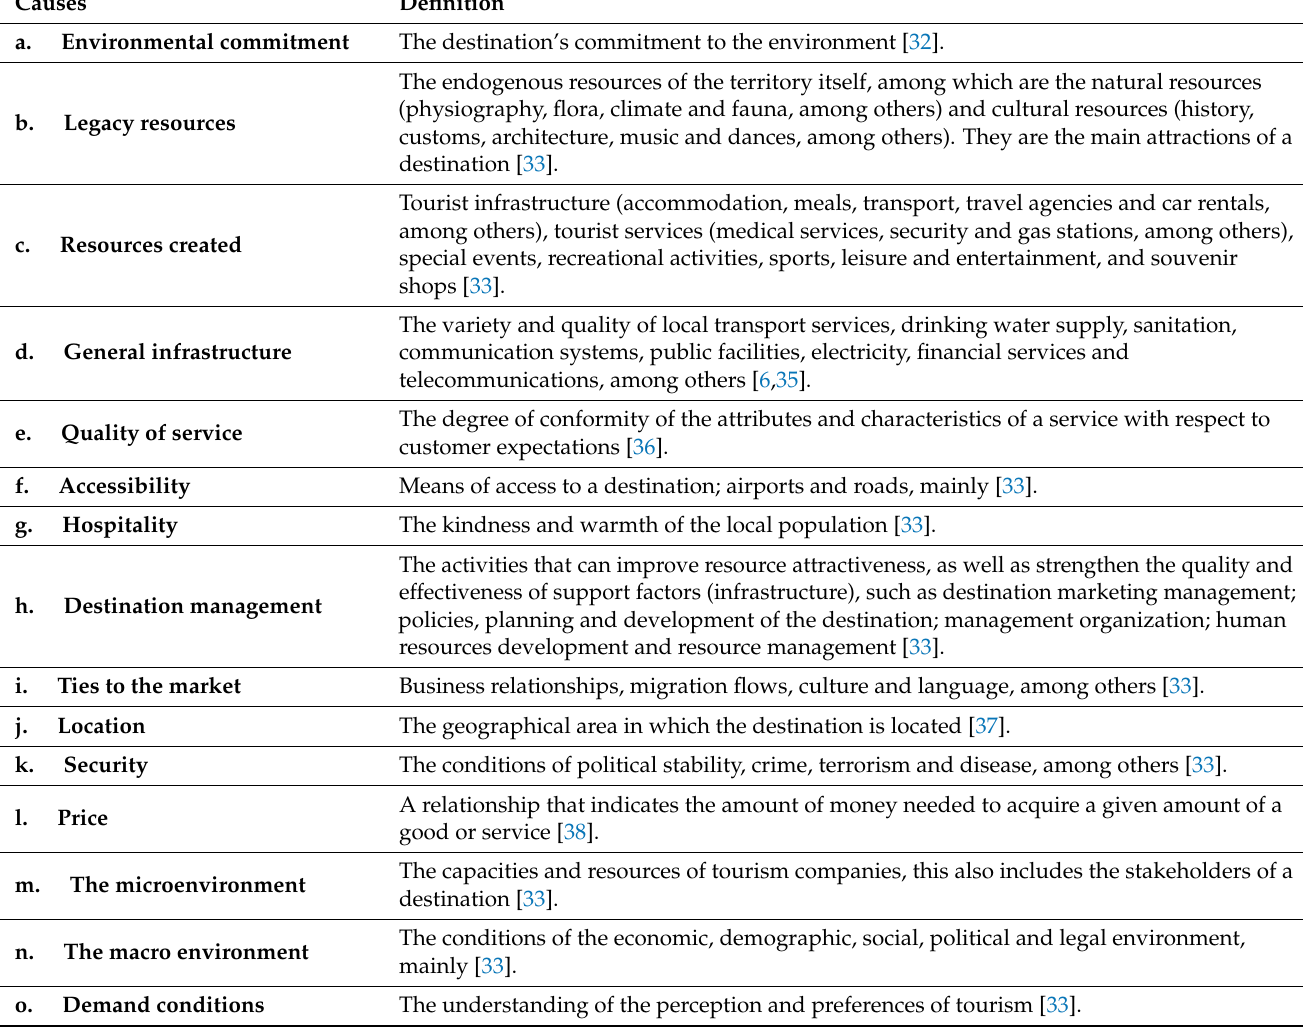
Table 1. Causes of tourist